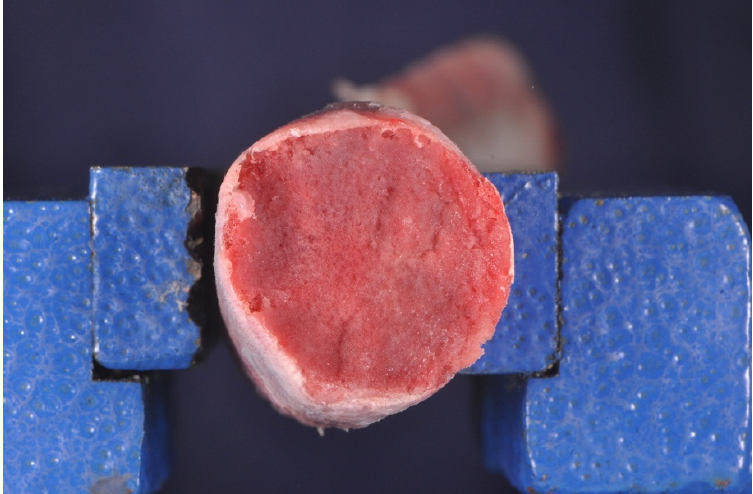
Figure 1. Fresh pig rib sample. The most distal region of the rib is smaller in diameter and has a great percentage of bone marrow.